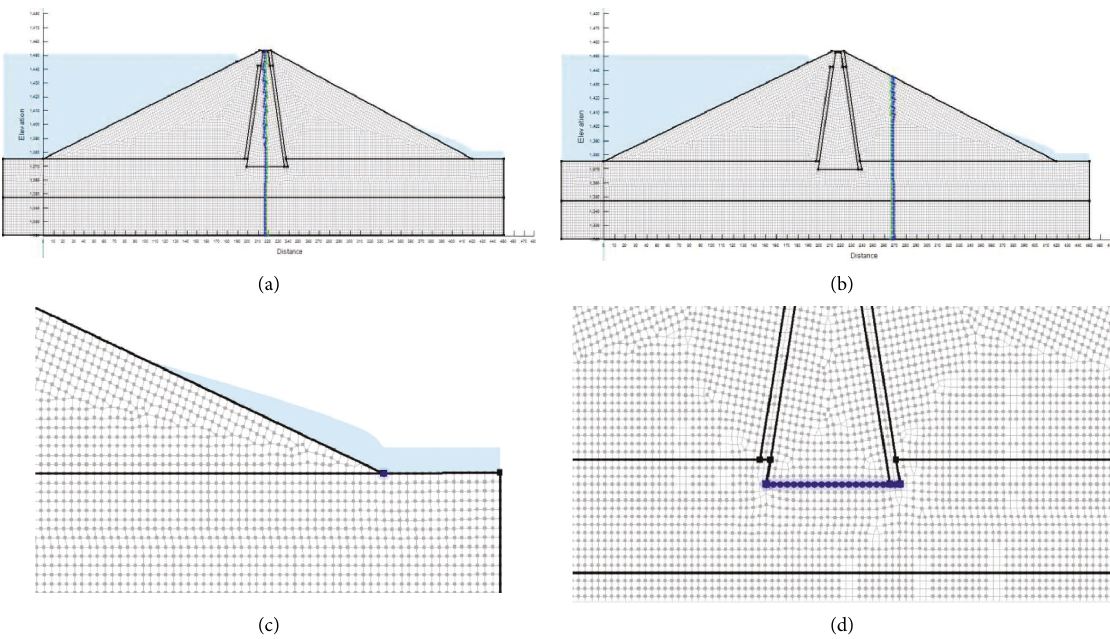
Figure 2: The studied locations. (a) Section 1. (b) Section 2. (c) Under the dam core. (d) Claw of the